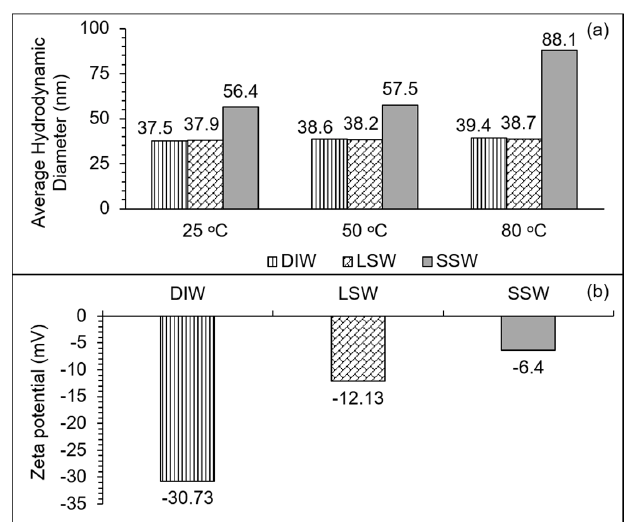
Figure 2. ( a ) Average particle size of the NPs dispersed in deionized water (DIW), low salinity water (LSW) and synthetic seawater (SSW) measured at varying temperatures. ( b ) Zeta potential measurements (25 °C) of the NPs in DIW, LSW and SSW.